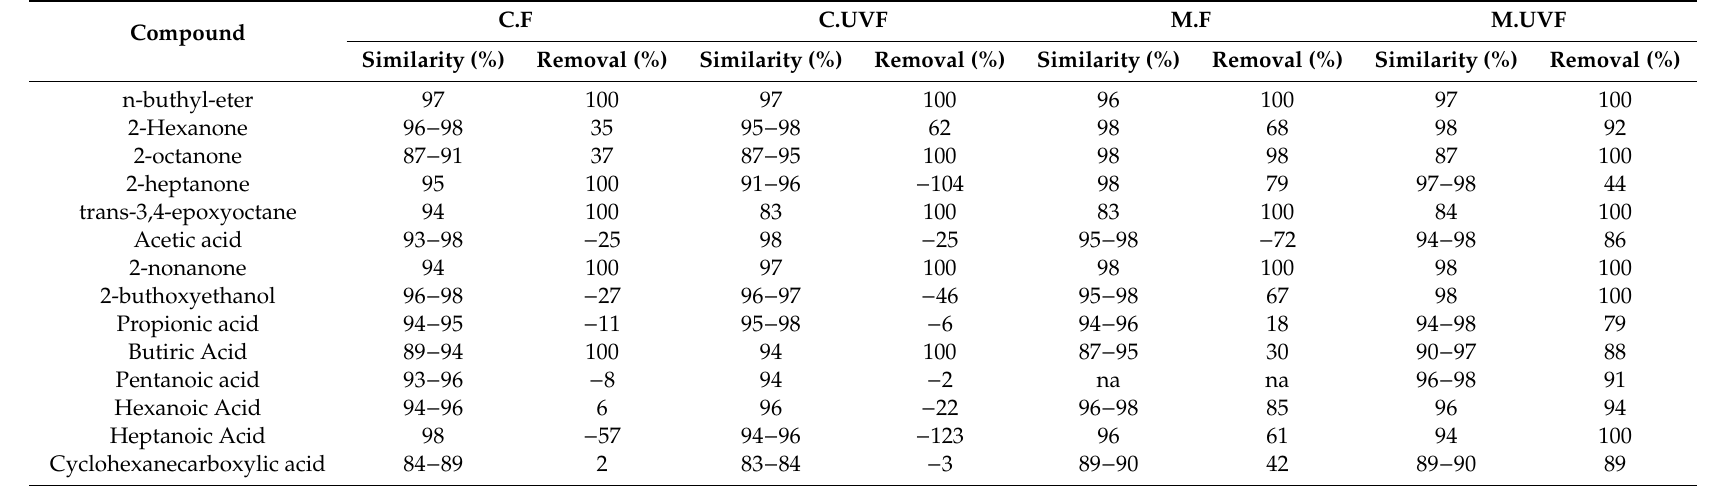
Table 4. Percent of similarity and removal of the organic volatile compounds detected in the feed and permeate samples collected after 20